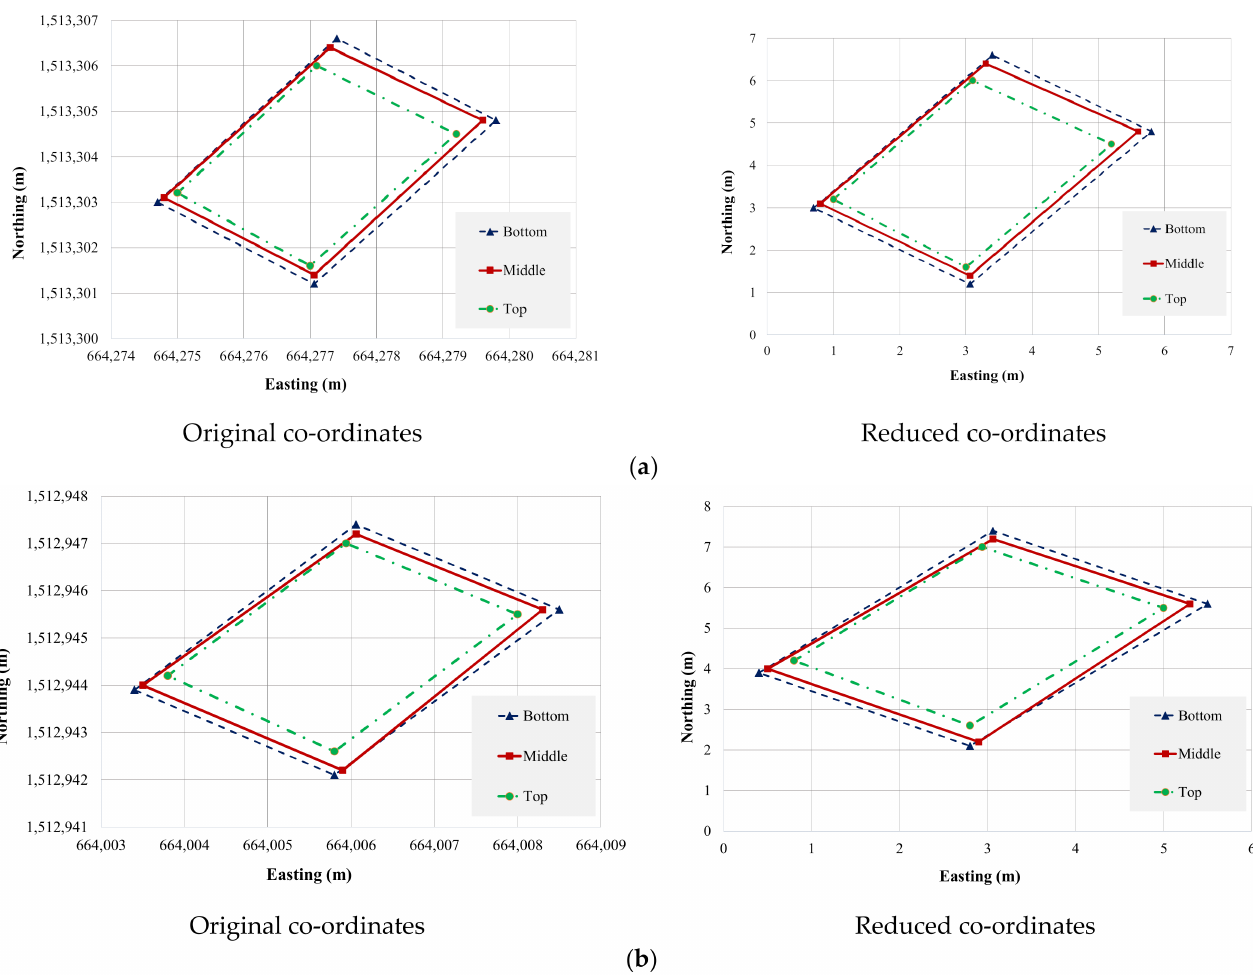
Figure 13. ( a ) East pylon section comparisons, and ( b ) west pylon section comparison.